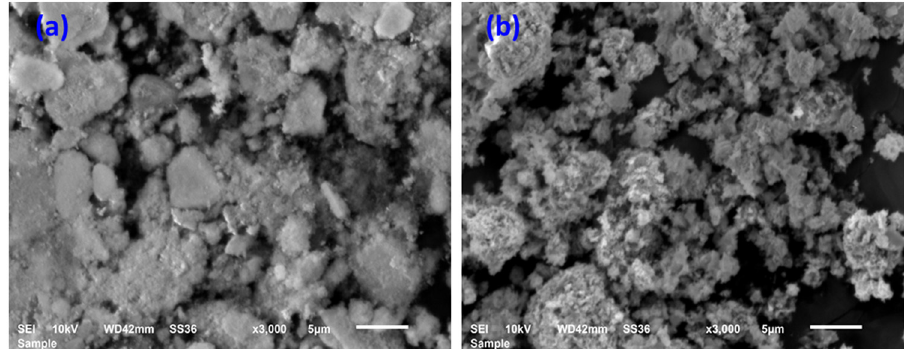
Figure 5: SEM images of: ( a ) undoped ZnO and ( b ) ZnO - Fe - 5.